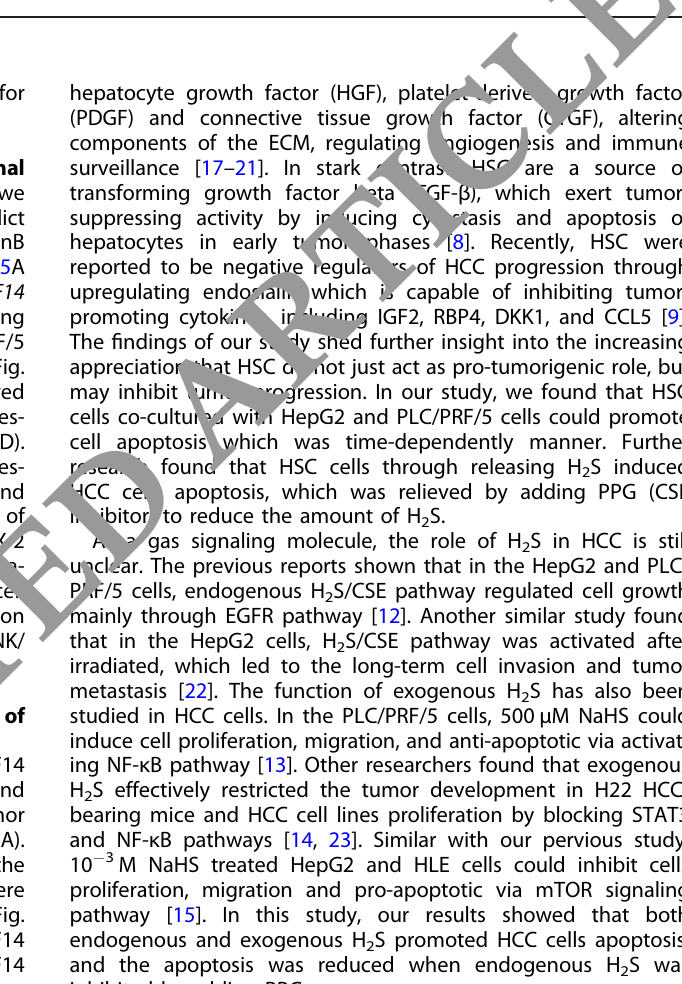
Fig. 5 H 2 S regulates TNFSF14 transcription through JNK/JunB signal. A Schematic overview of the predicted transcription factors of TNFSF14 gene by PROMO dataset (upper) and JunB binding sites on TNFSF14 promoter predicted with JASPAR website (lower). B ChIP assays for JunB binding onto TNFSF14 promoter were carried out in HepG2 (upper) and PLC/PRF/5 (lower) cells. The right panel showed the statistical analysis for the ChIP assay. C NaHS was used to treat HepG2 (left) and PLC/PRF/5 (right) cells for 0, 1, 2, 8, and 24 h. Expression of p-JunB in nuclear of HCC cells was detecting using immuno fl uorescence staining, and Nuclei and p-JunB were stained with DAPI (blue) and FITC (green), respectively. The image is representative of three independent experiments. D The effects of different time of NaHS treatment on the expression of p-JunB in the nuclear and cytoplasm were analyzed with Western blotting in the HepG2 cells and PLC/PRF/5 cells. E The expression levels of p-JunB protein were detected by Western blotting in the HCC cells under exogenous and endogenous H 2 S treatment. F Western blotting for the effects of PPG (CSE inhibitor) and SP600125 (p-JNK inhibitor) in the expressions of JNK/p-JNK, JunB/p-JunB, and TNFSF14 proteins in HepG2 and PLC/PRF/5 cells. All Bars, ± SD; n = 3; * P < 0.05 compared with control group in HepG2 cells, # P < 0.05 compared with control group in PLC/PRF/5